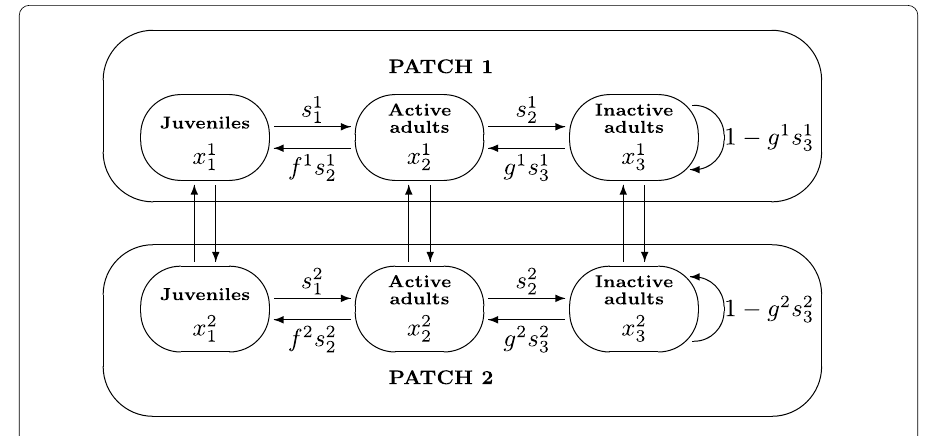
Figure 1 Transition graph of a population structured in three classes and two patches